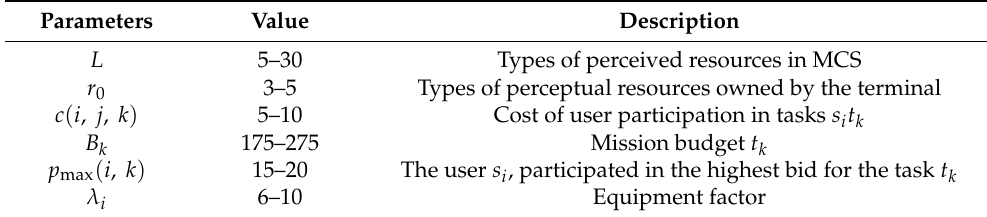
Table 2. Main simulation